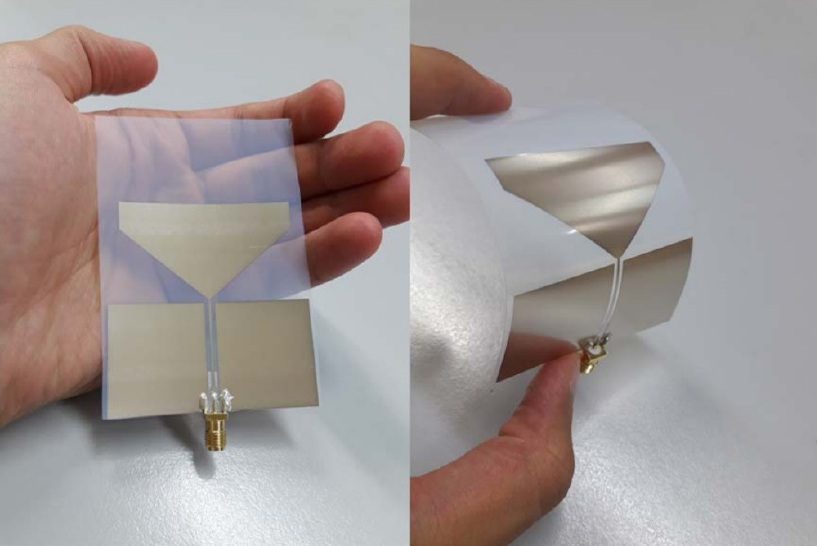
Figure 22. Fabricated prototype of the modified microstrip patch antenna (reused with permis- sion) [132].